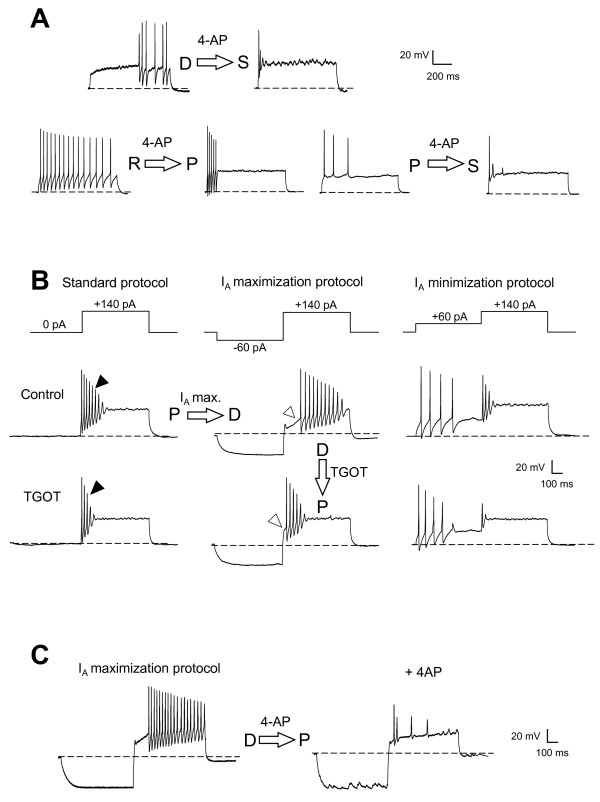
Transient potassium current shapes the firing profile. A: Modulation of the firing profile following the application of 4-AP, a blocker of transient K+ currents (IA), in three different lamina II neurons. B: Firing profile changes exhibited by a phasic neuron (left panels, standard protocol) submitted to conditioning hyperpolarizing (middle panels) or depolarizing prepulse (right panels) aimed at maximizing or minimizing IA current, respectively. In these three conditions, the effect of TGOT application (bottom traces) is compared to the control situation (upper trace). Black arrowheads indicate the accommodation in spike frequency. White arrowheads show the delay time before obtaining the first action potential. C: Effect of 4-AP on a neuron exhibiting a delayed firing profile after a conditioning hyperpolarizing prepulse producing a large IA current. Dashed lines represent -60 mV.